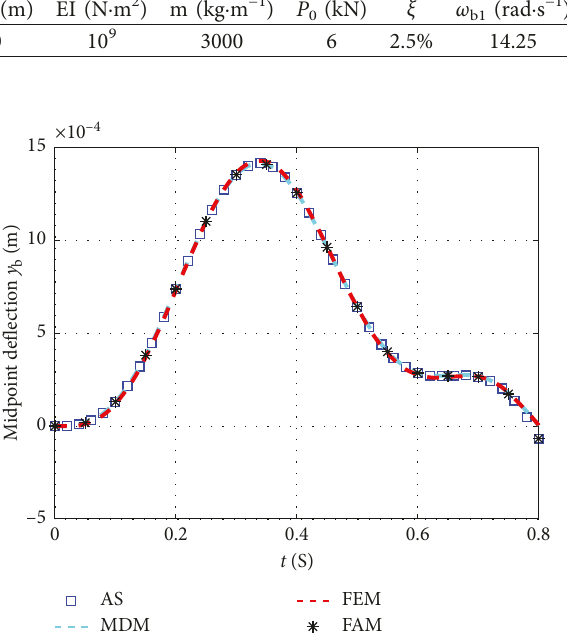
Figure 4: Midspan vertical displacement time history curve.